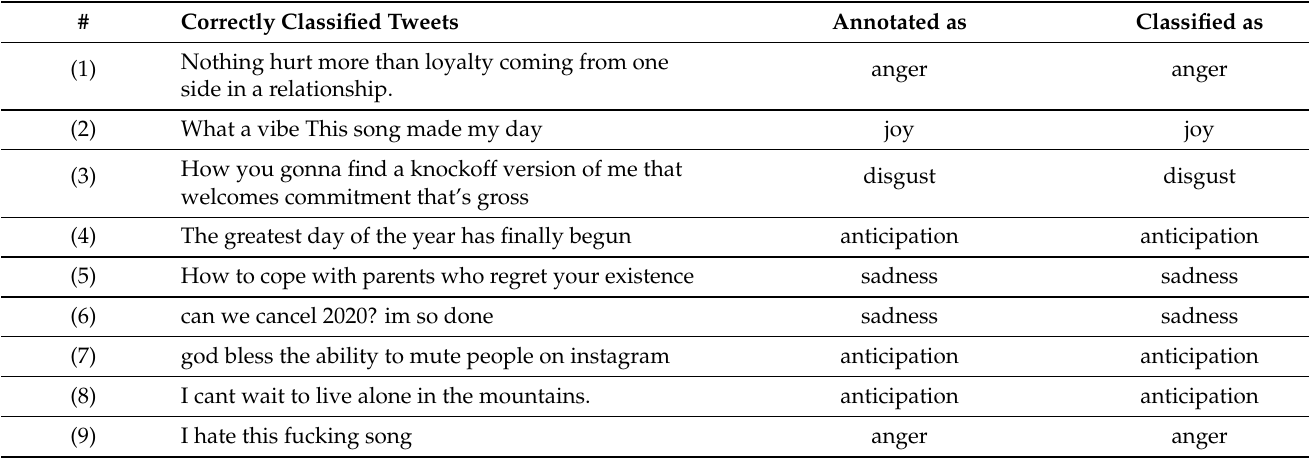
Table 2. Examples of the classified